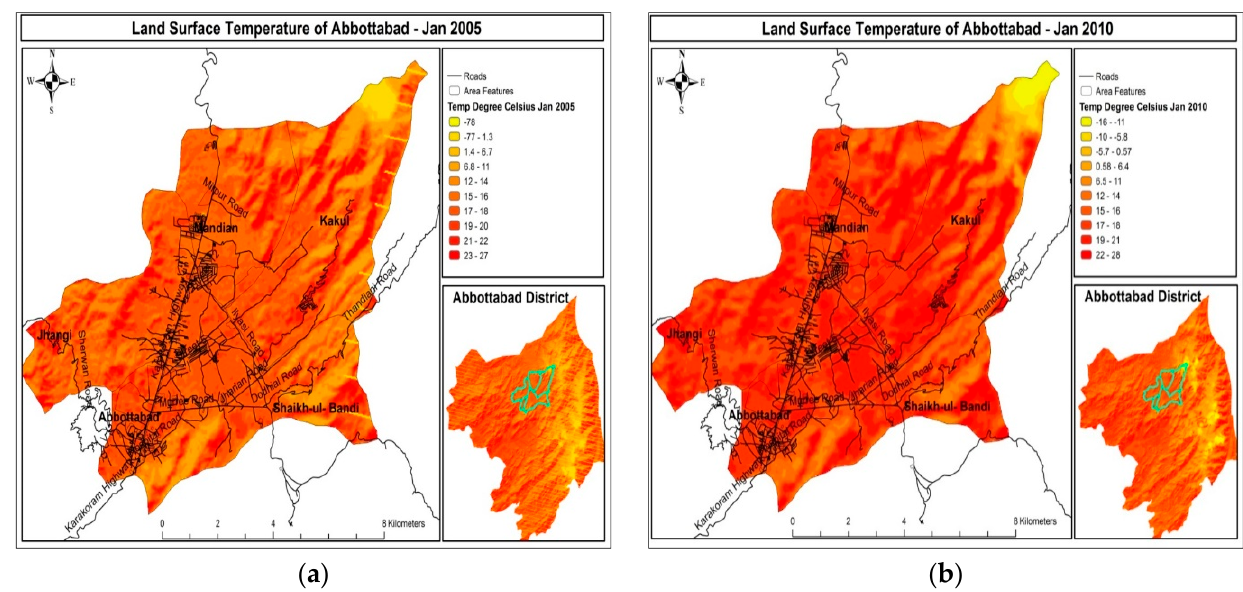
Figure 8. ( a ) LST of Abbottabad of Jan 2001–2005 and ( b ) LST of Abbottabad of Jan 2006–2010.